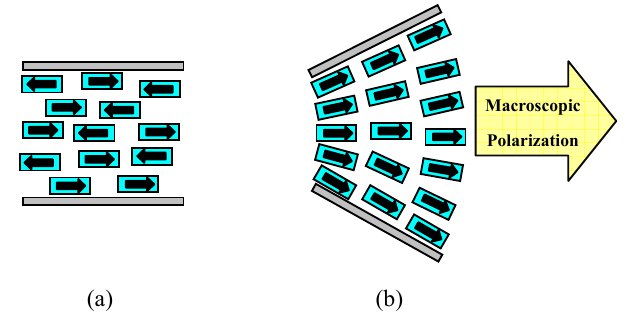
Fig.1 Molecular model of flexoelectric